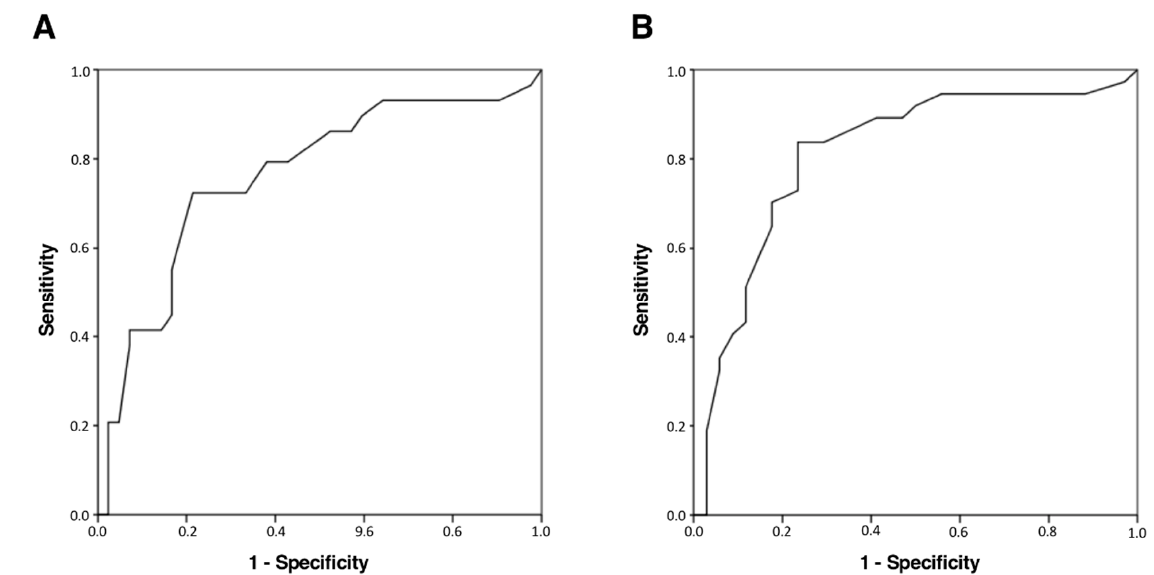
Figure 1. ROC curves for ( A ) low general functioning (mRS) and ( B ) no hand functioning (SULCS) at 12 weeks according to NIHSS scores at admission. mRS = modified Rankin Scale; NIHSS = National Institutes of Health Stroke Scale (NIHSS); ROC = Receiver operating characteristic; SULCS = Stroke Upper Limb Capacity Scale .